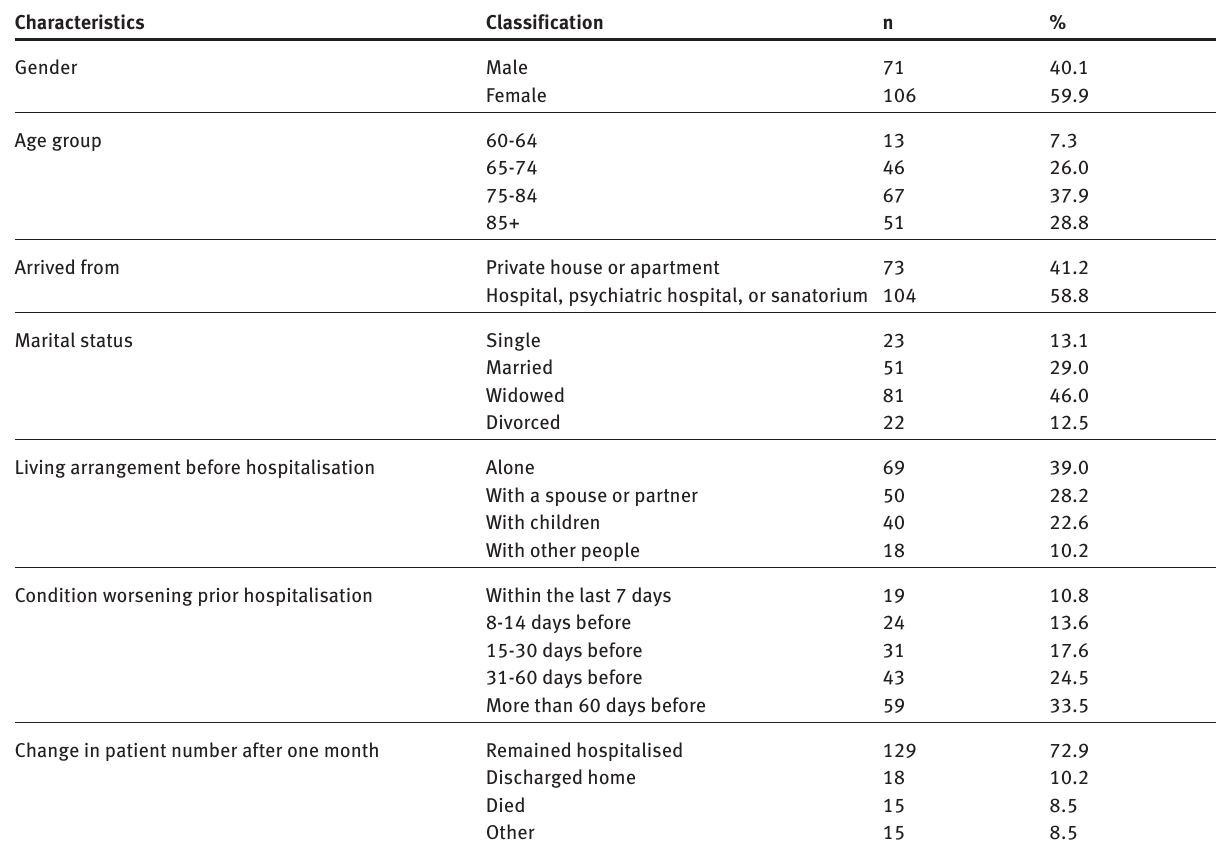
Table 1: Sociodemographic data of the study subjects (n = 177)